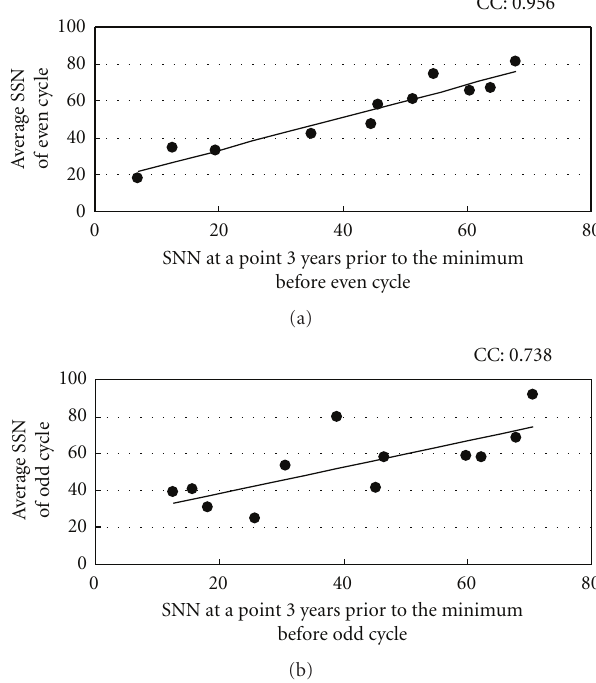
Figure 8: (a) Average sunspot number divided at a point three years before the minimum versus the sunspot number at the dividing point for even numbered cycles. (b) is the same as (a) but showing for odd numbered cycles.